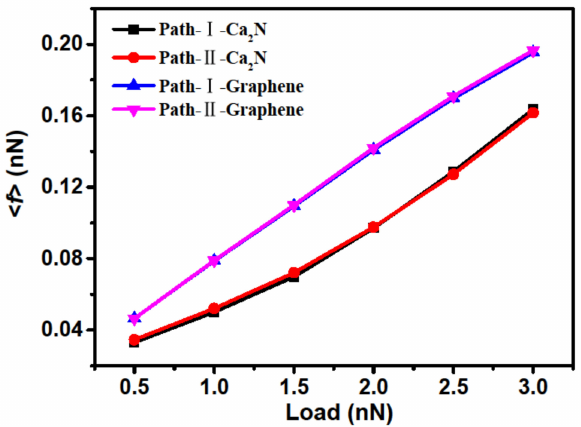
Figure 5. Comparison of mean friction force < f > between Ca 2 N and graphene